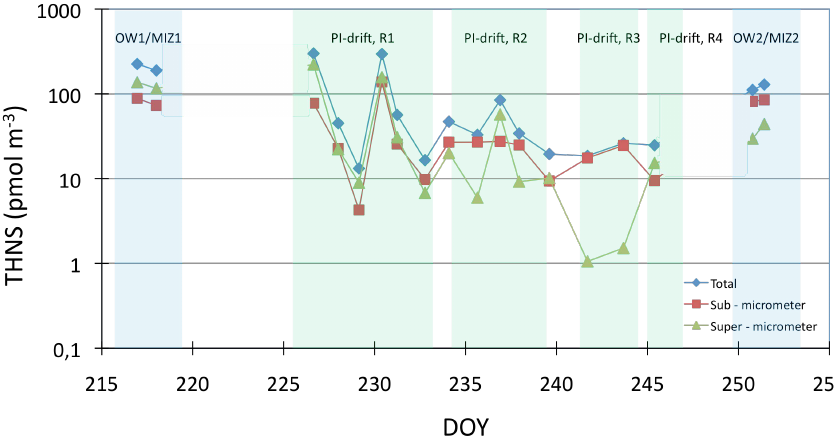
Fig. 3. Temporal variation of particulate THNS (total hydrolysable neutral sugar) mass concentration (pmolm − 3 ) , grouped in the sub- and super-micrometer size ranges. The division into four separate regimes (R1–4) during ice drift (PI-drift: DOY 225–245), based on the analyses of the surface energy budget (see Sect. 4.1 for details), is indicated by light-green panels. The inward and outward OW and MIZ stations are indicated by light-blue panels. The thin line connecting the subsequent samples is inserted to help the eye to separate the three categories of THNS (total, sub-micrometer,